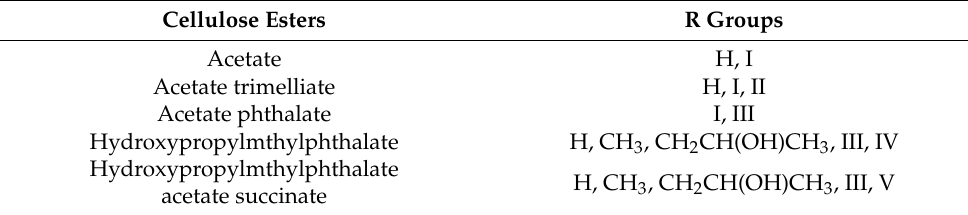
Table 2. Main cellulose ester derivatives according to R groups [128].